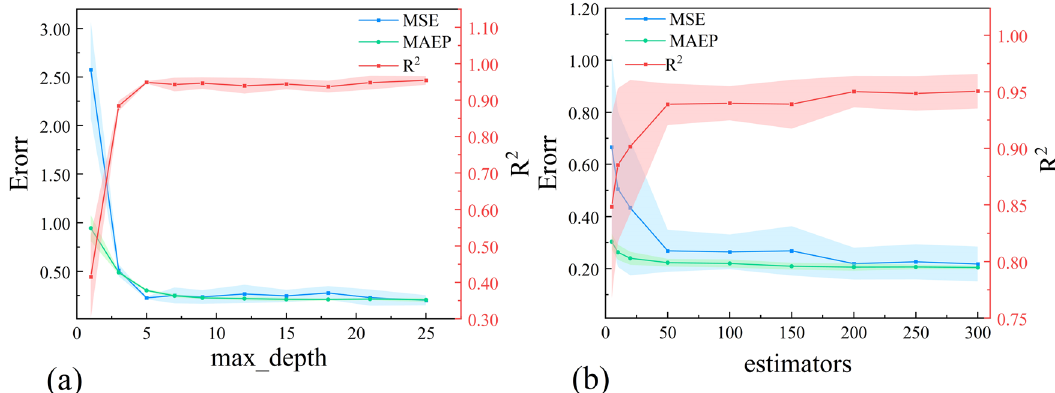
Fig. 5 Performance of the model with different hyperparameter values. a Variation of AdaBoost model performance with maximum depth of decision tree, b Variation of AdaBoost model performance with the number of base estimators.